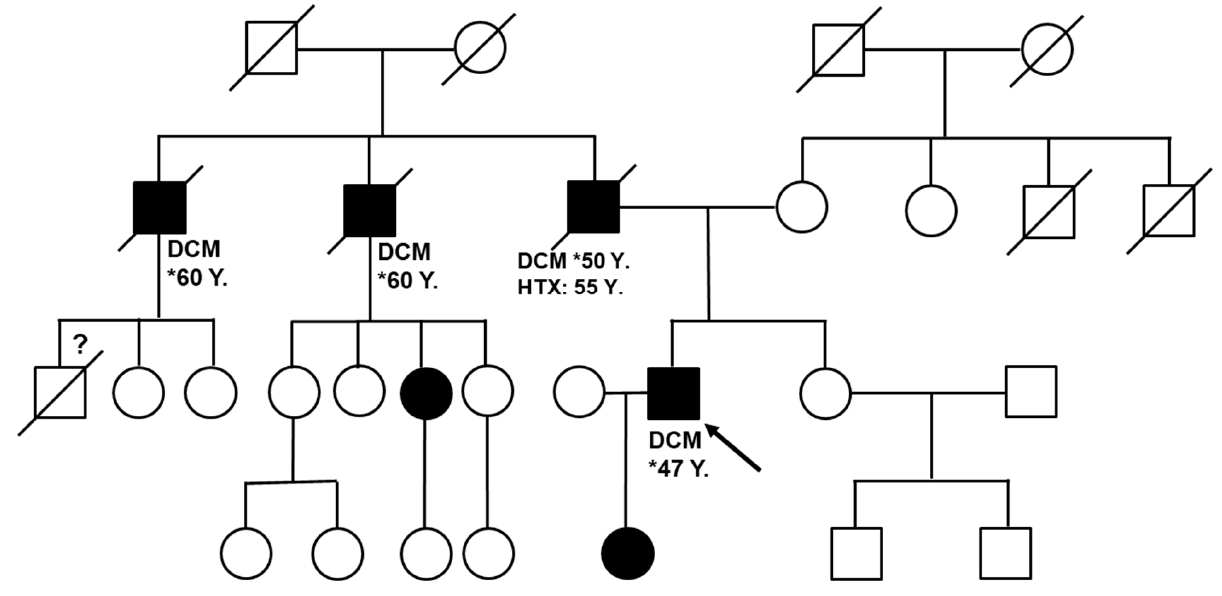
Figure 1. Patient pedigree. The proband is a 47-year-old male (depicted by an arrow). Square boxes denote males while the circles denote females. Squares or circles filled with dark areas denote individuals with the LMNA mutation (NM_170707.3: c. 481 G > A: p. E161K). Crossed squares or circles denote that individuals have already passed away. Y = years, DCM = dilated cardiomyopathy, HTX = heart transplantation, * year of DCM diagnosis.